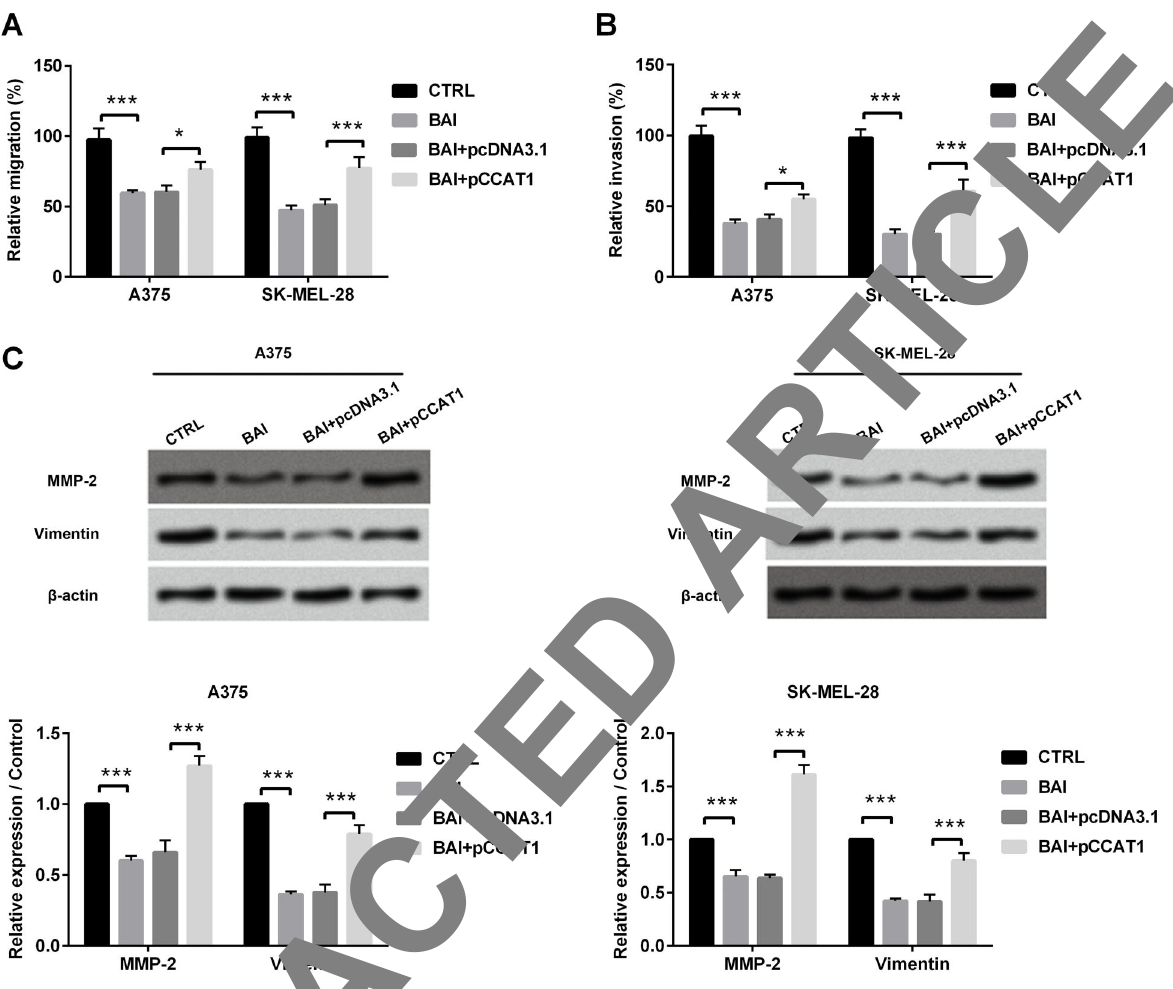
Figure 5. Baicalein (BAI) suppressed the migration and invasion of malignant melanoma via regulating CCAT1. A and B , Transwell assay was utilized to test the relative cell migratory and invasive rates. C , Western blot was utilized to analyze MMP-2 and vimentin expression levels in melanoma cells treated with BAI or BAI + pCCAT1. The relative expression of proteins was normalized by b -actin. Data are reported as mean ± SD. *P o 0.05, ***P o 0.001 (ANOVA). CTRL: